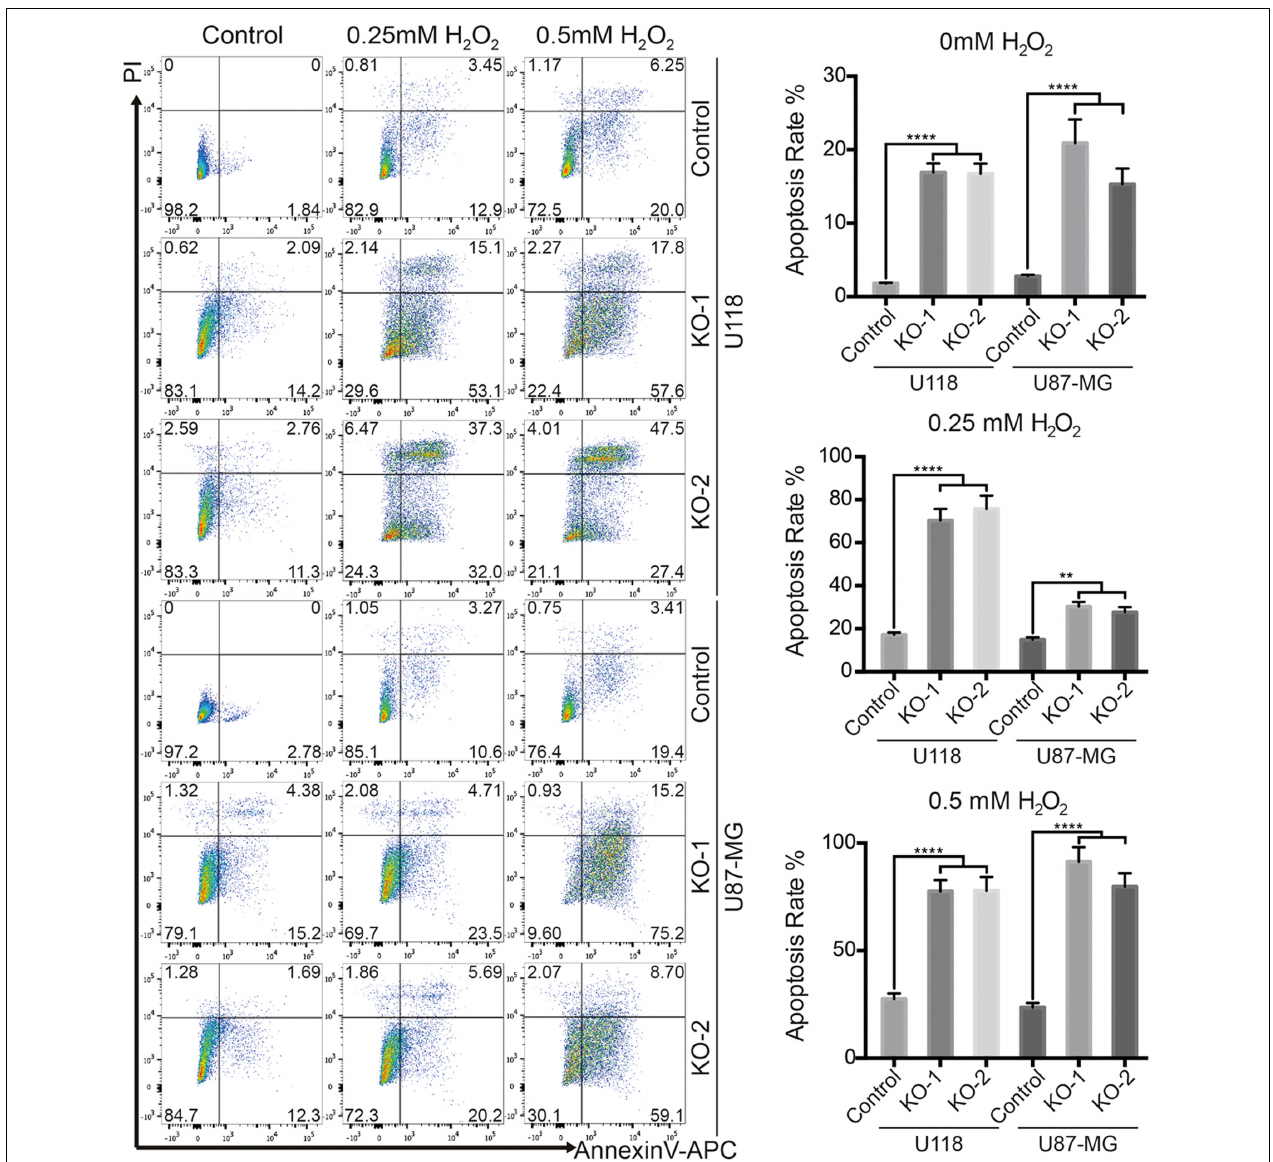
FIGURE 3 | HAX-1 knock-out enhanced apoptosis of U118 and U87-MG cells under oxidative stress. Cell apoptosis assay showed that HAX-1 knock-out obviously increased the apoptosis of U118 and U87-MG cells. Apoptosis rates were measured by FCM analysis after Annexin-APC and PI staining. Three individual experiments were performed for each group. ∗ P < 0.05, ∗∗ P < 0.01, ∗∗∗ P < 0.001, ∗∗∗∗ P <